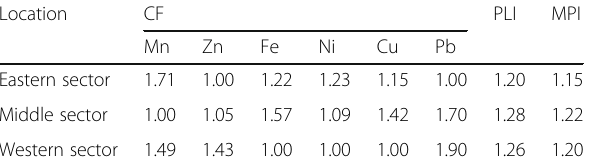
Table 9 The Pearson ’ s correlation coefficient ( r ) between heavy metals in water Metal